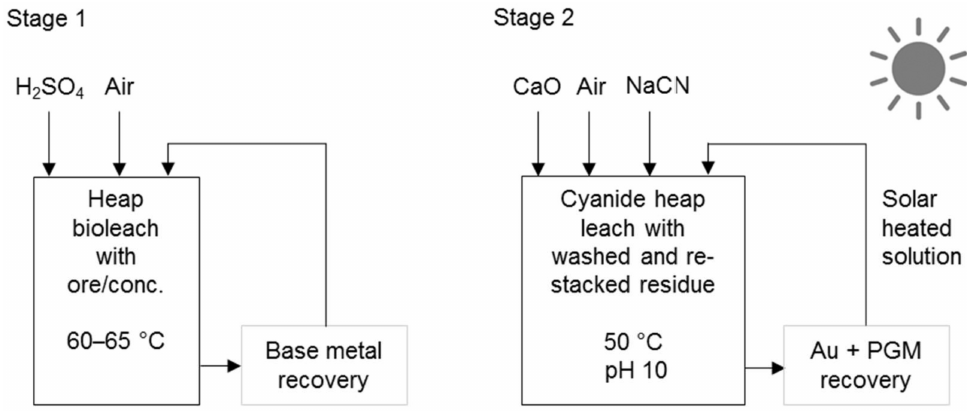
Figure 9. Schematic diagram of the sequential heap leach process (adapted from Mwase et al.